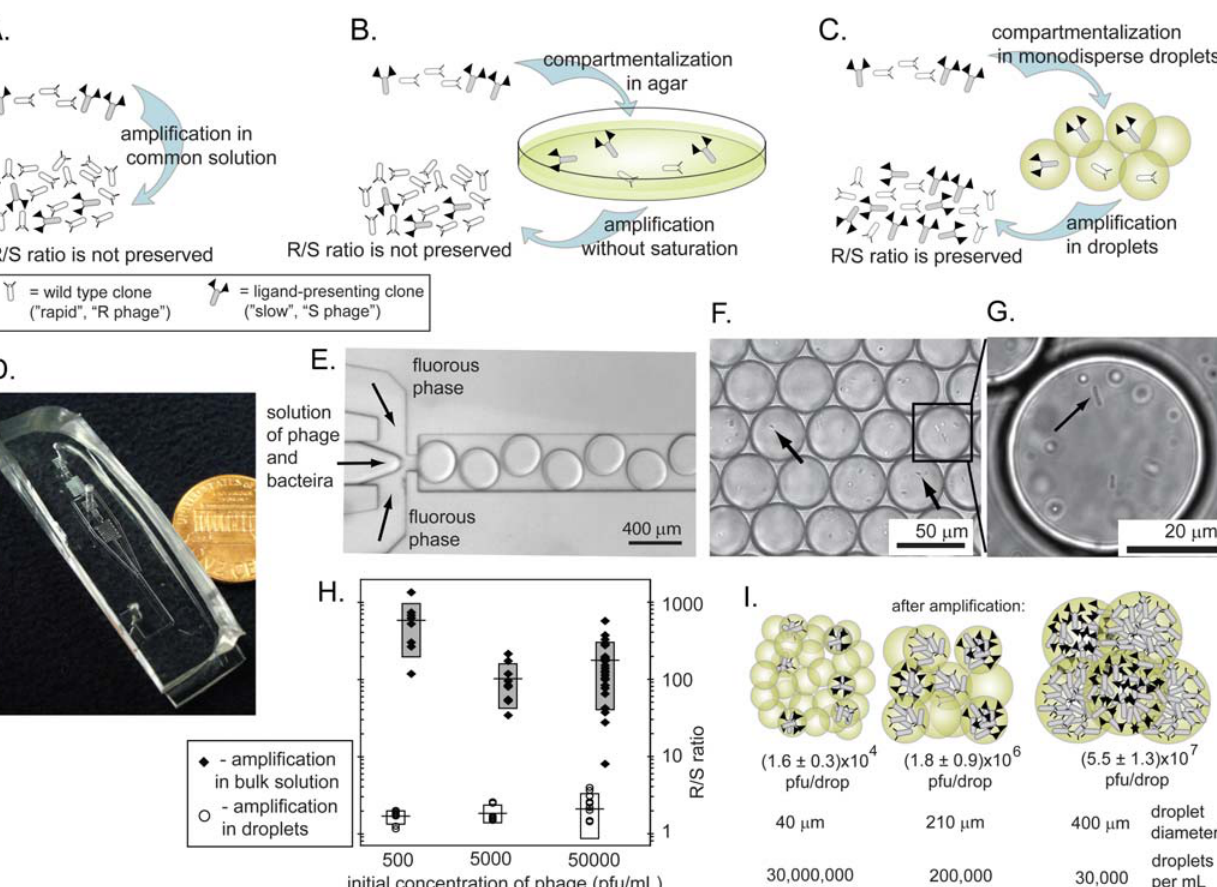
Figure 9. Amplification methods that prevent competition between the phage. (A) Rapid R and slow S clones compete in the same solution. The R/S ratio is not preserved. (B) R and S are isolated in agar, but they do not amplify to completion. The R/S ratio is not preserved. (C) Amplification in monodisperse droplets isolates each phage to its own droplet; amplification to saturation preserves R/S ratio. (D) Photograph of the microfluidic device we used to isolate phage in separate monodisperse droplets. (E) Optical micrograph of the microfluidic device that generates droplets containing bacteria and phage in LB media suspended in a perfluorinated solvent as the carrier fluid. (F) Droplets contain bacteria (arrows) and phage. We generated these drops from a solution containing phage with an initial concentration such that each drop of a specific volume contains one or zero particles of phage. (G) Dividing bacteria inside the droplet. (H) Comparison of the amplification of a mixture of R and S phage (see Figure 6) in bulk solution or in the droplets. The R/S ratio is preserved in droplets and it increases by 100 to 300-fold in bulk solution. (F) The size of the droplets is important; the number of phage generated per droplet is proportional to the size of the droplet. Uniform amplification, thus, can be obtained in monodisperse droplets and not polydisperse emulsions. Reproduced from Derda et al. [66] with